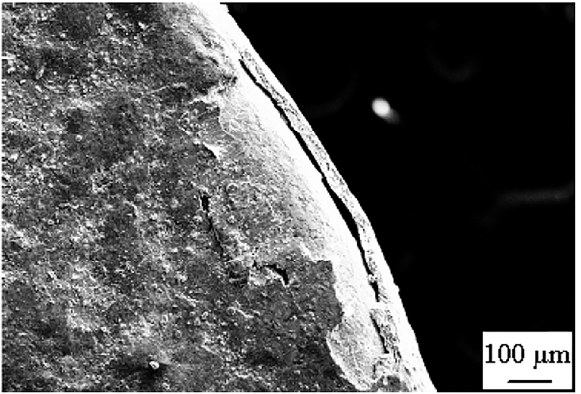
Fig. 14 Scanning electron micrograph image of the edge of Zn ‒ Sn rivet’s head showing part of the coating was missing. Reproduced with permission from Ref. [61], © Trans Tech Publications Ltd,